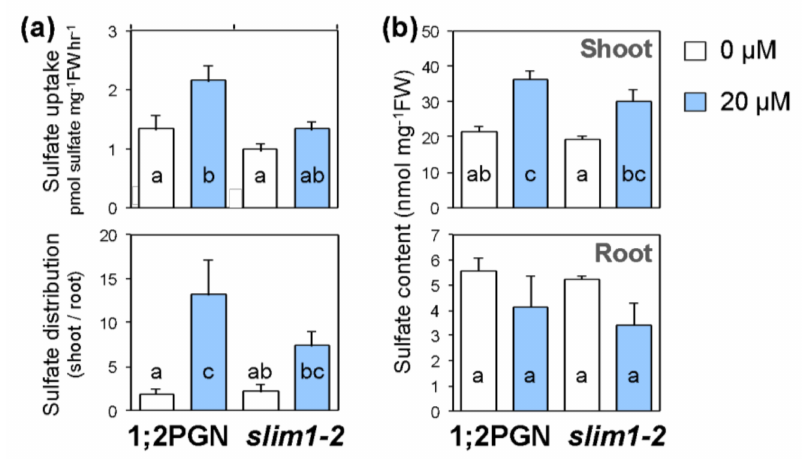
Figure 2. E ff ects of Cd treatment on sulfate uptake, distribution, and content in 1;2PGN and slim1–2 plants. ( a ) The absolute values of [ 35 S] sulfate uptake rates (upper graph) and sulfate distribution shown as the shoot / root ratio of [ 35 S] sulfate accumulations (lower graph). ( b ) Sulfate content in shoots (upper graph) and roots (lower graph) of 1;2PGN and slim1-2 . Plants were grown for 10 days on MGRL agar medium containing 0 (white bars) or 20 (light blue bars) µ M CdCl 2 . Sulfate content was determined by ion chromatography. The average values are indicated with error bars denoting SEM ( n = 4–7 in a, n = 4 in b). Di ff erent letters indicate significant di ff erences among experimental groups (Tukey-Kramer test; p <